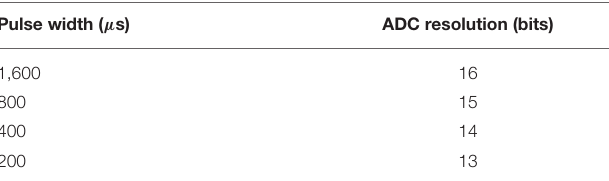
TABLE 1 | LED pulse width configurations tested and the correspondent ADC resolution.